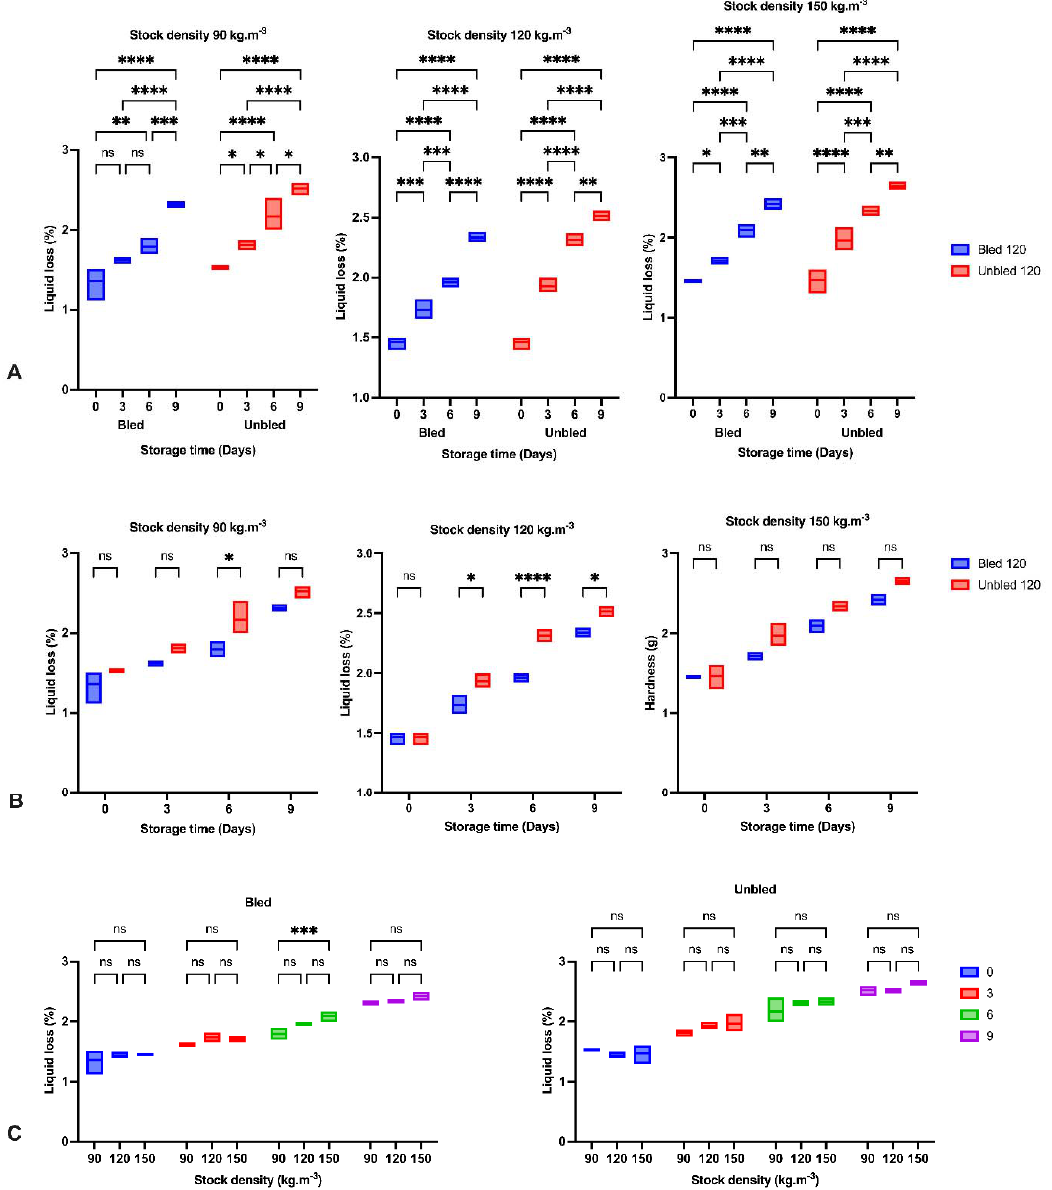
Figure 3. Liquid loss percentage: ( A ) During the storage time (0, 3, 6 and 9 days) in bled and unbled groups at different stock densities (90, 120 and 150 kg · m − 3 ); ( B ) In bled and unbled groups at each storage time (0, 3, 6 and 9 days) and at different stock densities (90, 120 and 150 kg · m − 3 ); ( C ) In different stocking densities (90, 120 and 150 kg · m − 3 ) during storage time (0, 3, 6 and 9 days) in bled and unbled groups; ( p < 0.05, Tukey’s multiple comparisons test; ns: non-significant; * p < 0.05; ** p < 0.01; *** p < 0.001; **** p < 0.0001). Box plots showing line at mean. Box plots showing the line at upper quartile, lower quartile and at the